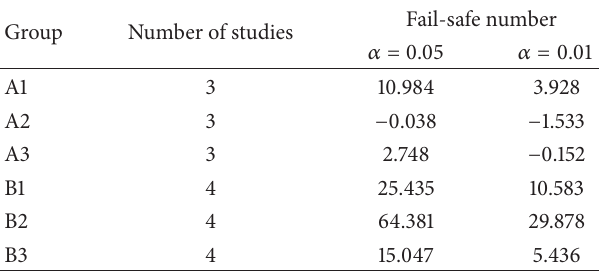
Table 3: Fail-safe numbers of all groups for studies with no